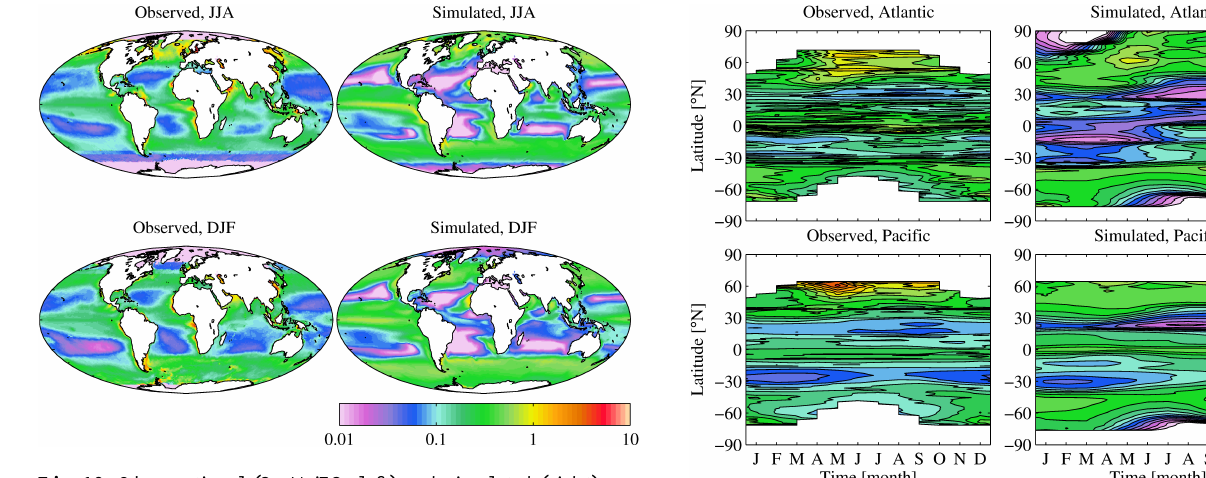
Fig. 10. Observational (SeaWiFS; left) and simulated (right) surface chlorophyll for northern summer (June–July–August; top ) and northern winter (December–January–February; bottom ). Concentrations in mg chl. m − 3 . Fig. 11. Hovmöller diagrams of observational (SeaWiFS; left) and simulated (right) monthly surface chlorophyll, averaged zonally for the Atlantic (top) and Pacific (bottom) basins. Concentrations in mgchlm − 3 .